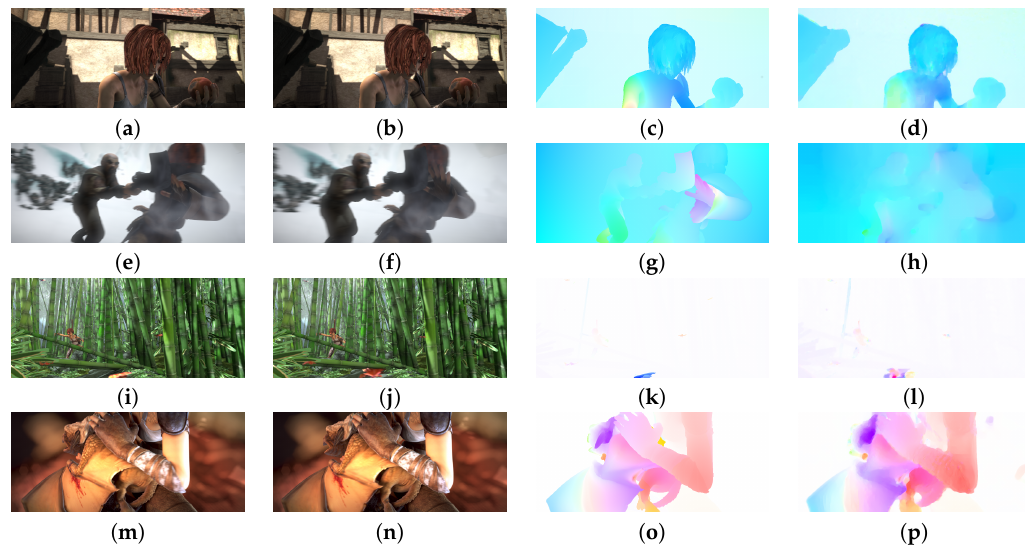
Figure 13. Image sequences used to estimate model parameters. In the parameter estimation, we used the first two frames of each considered sequence: ( a – d ) the frames of the alley_1 sequence, the ground truth, and our results, respectively. ( e , f ) the ambush_2 sequence, ( g ) the ground truth, and ( h ) our result. ( i , j ) frames of the bamboo_2 sequence, ( k ) the ground truth, and ( l ) our result. ( m , n ) the frame of bandage_1 sequence ( o ) the ground truth, and ( p ) our results.